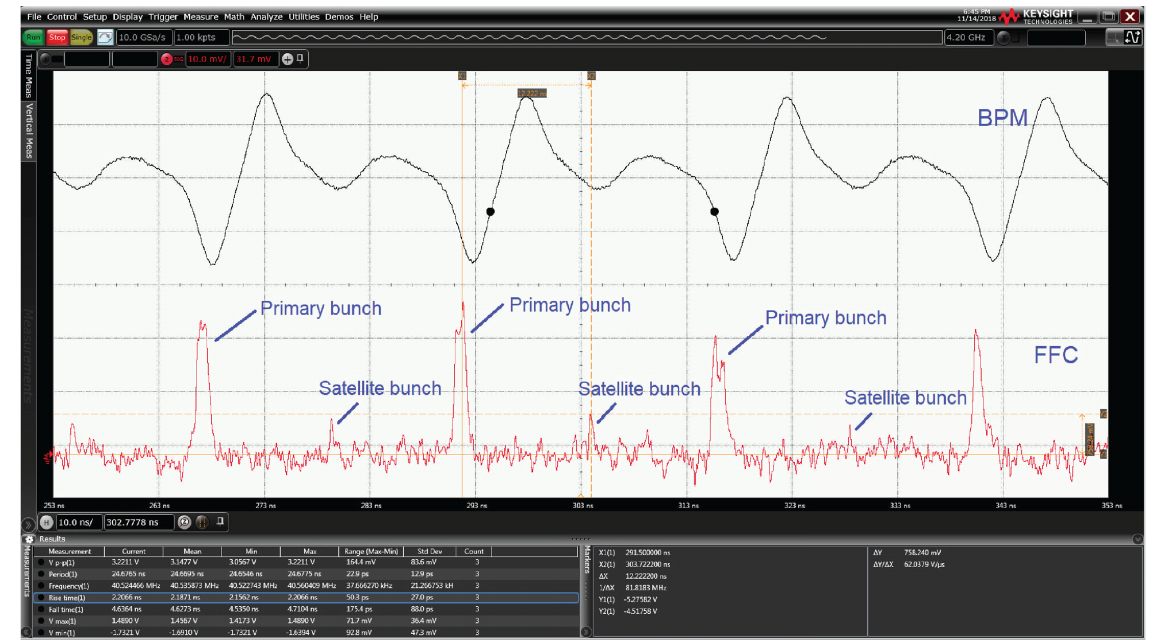
FIG. 29. Measured beam longitudinal bunch shape by a fast Faraday